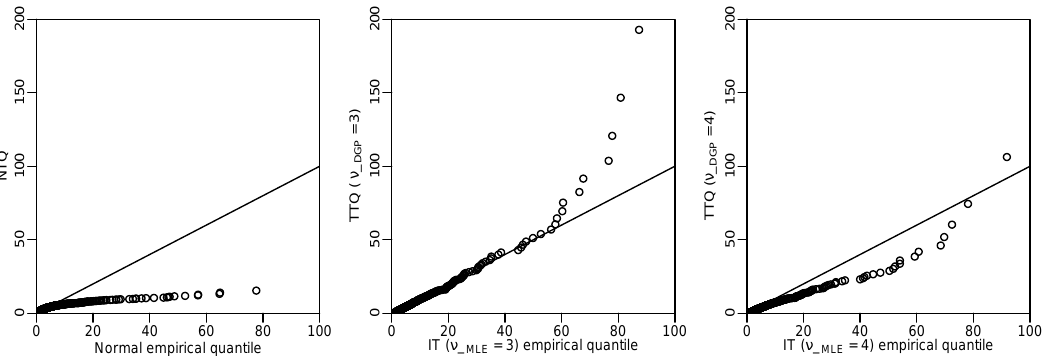
Figure 4. Financial data: Q-Q plots of the Mahalanobis distances for the normal, IT ( ν MLE = 3), and IT ( ν MLE = 4) estimators.